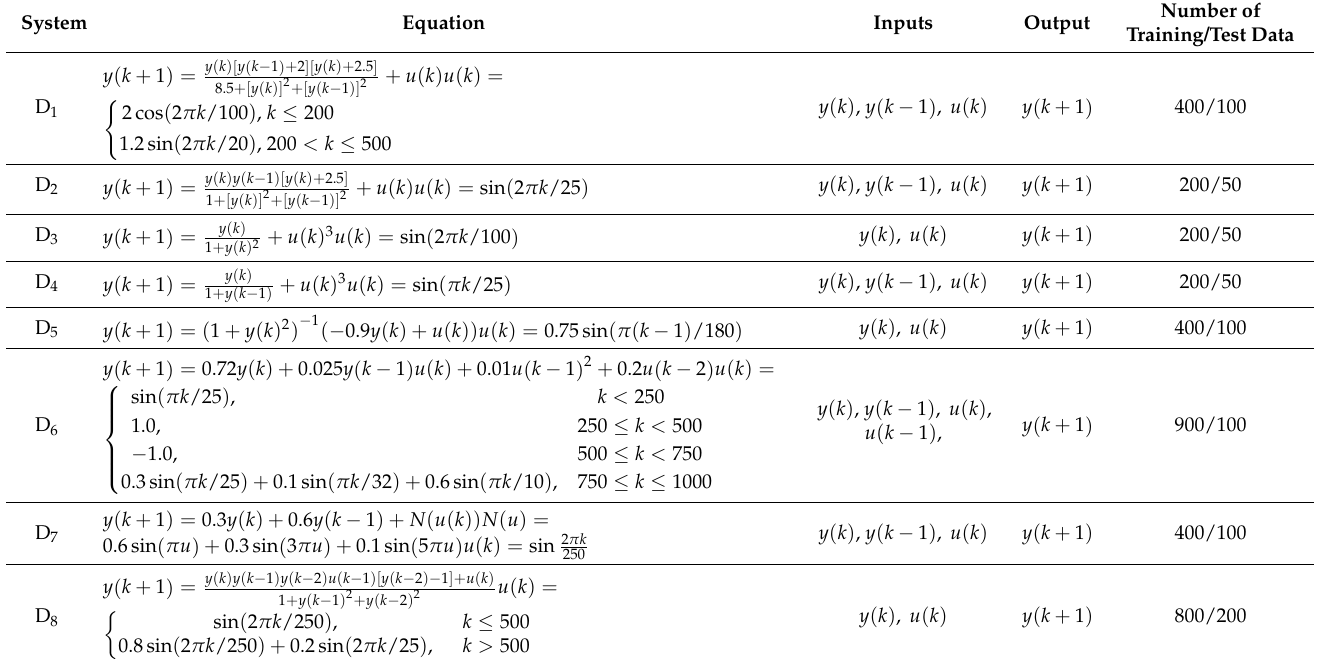
Table 9. Nonlinear dynamic systems